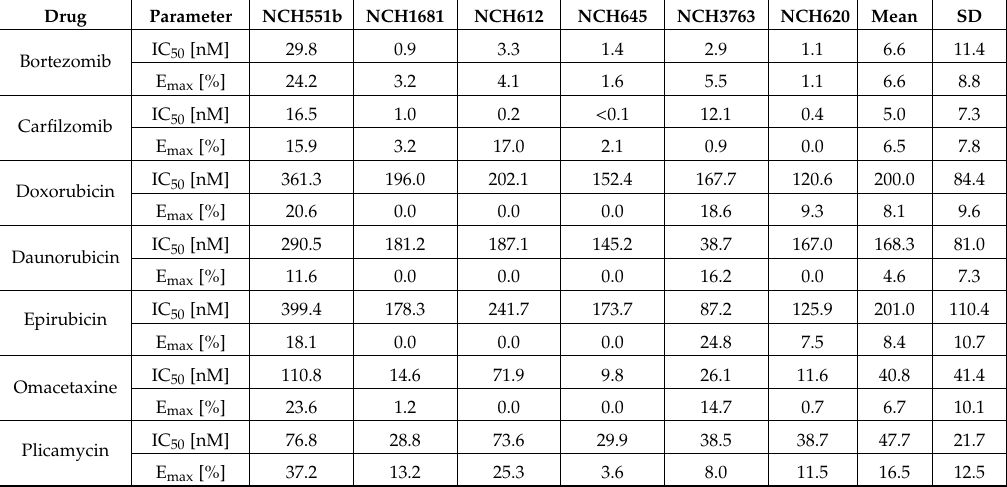
Figure 5. IC 50 values of candidate drugs. Mean IC 50 is marked by a horizontal line. Carfilzomib had the broadest range of drug sensitivity and had the greatest effect in NCH645 (red diamond), with an IC 50 below the lowest tested concentration of 0.1 nM. Table 1. Data obtained for candidate drugs on six IDH mut GSC